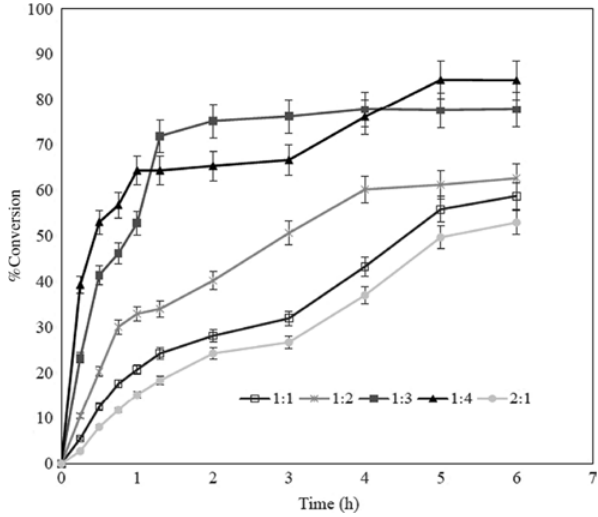
Figure 1: Influence of molar ratio of stearic acid to PEG 600 on reac- tion conversion at enzyme loading Fermase 0.5% (w/w), tempera- ture 70 ° C, speed of agitation 200 rpm, and molecular sieves